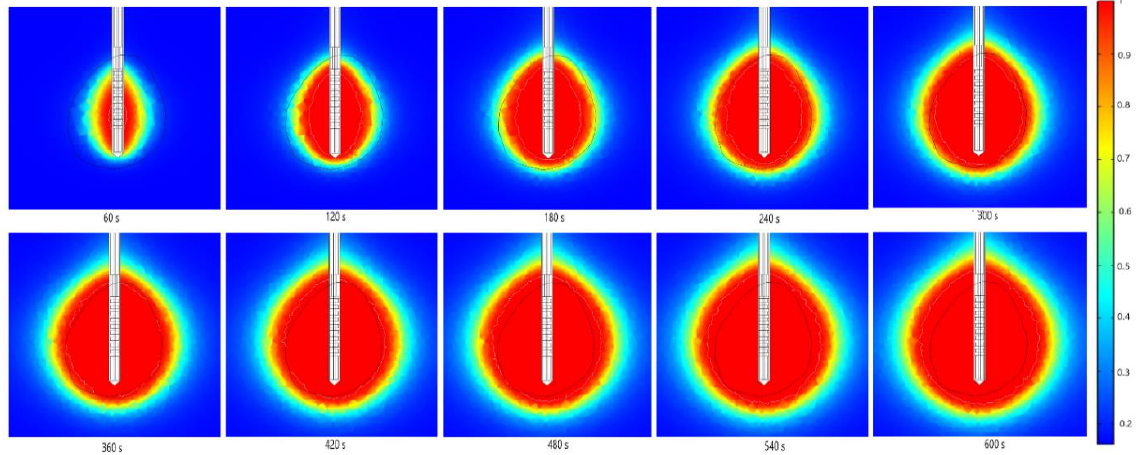
Figure 10. The time evolution of the fraction of necrotic tissue exposed to the microwave ablation at a frequency of 2.45 GHz and the input power of 13 W. The boundary of the tumoral tissue is marked by the black line.